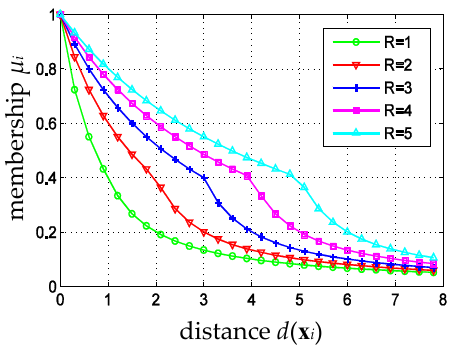
Figure 2. Membership function curve of Equation (1) for different R.